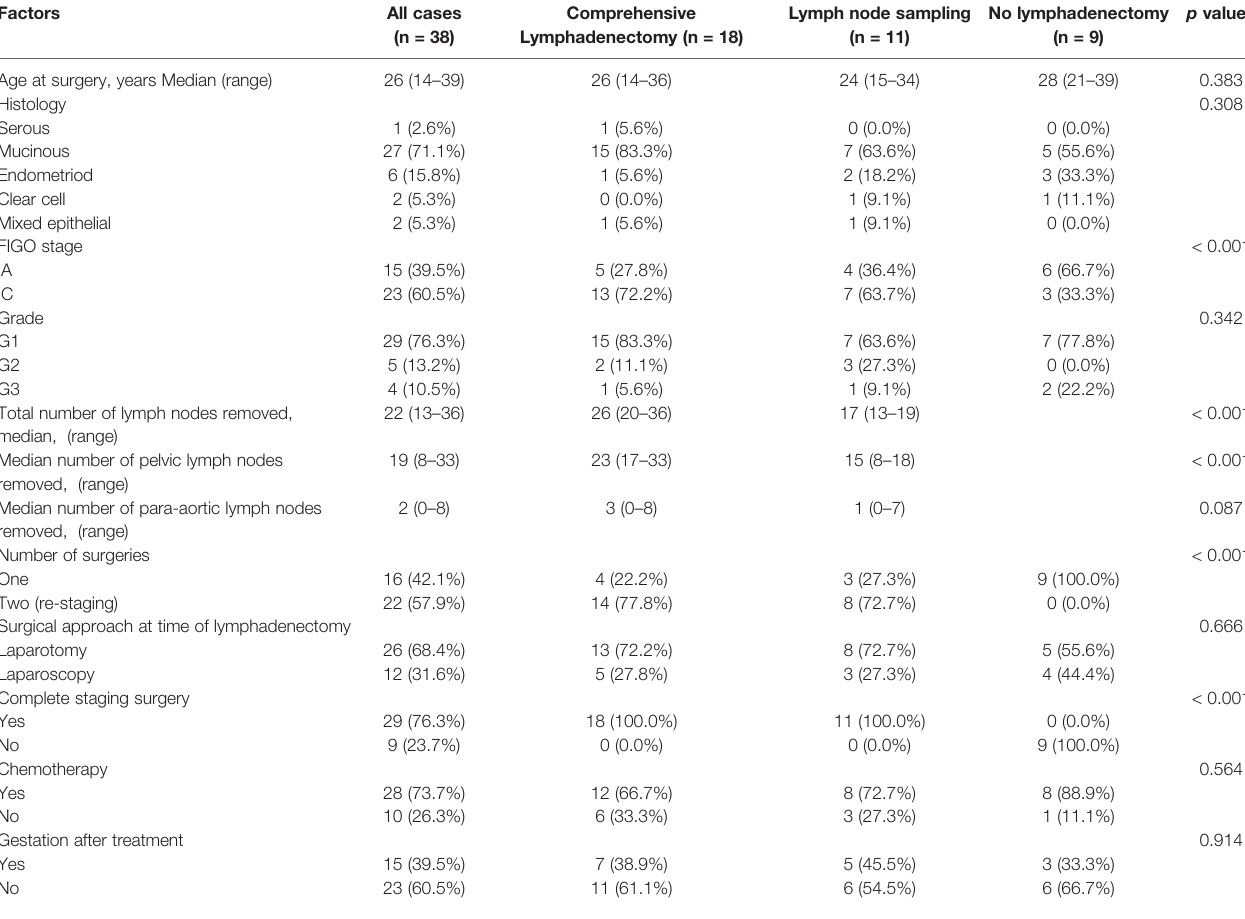
TABLE 1 | The clinical oncological data of all 38 patients with